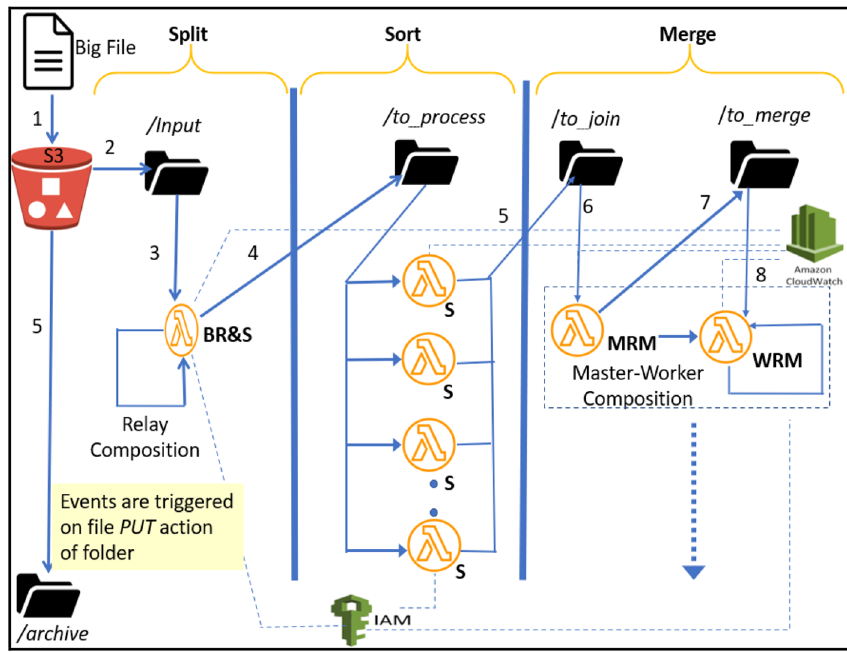
Fig. 6 The deployment diagram of